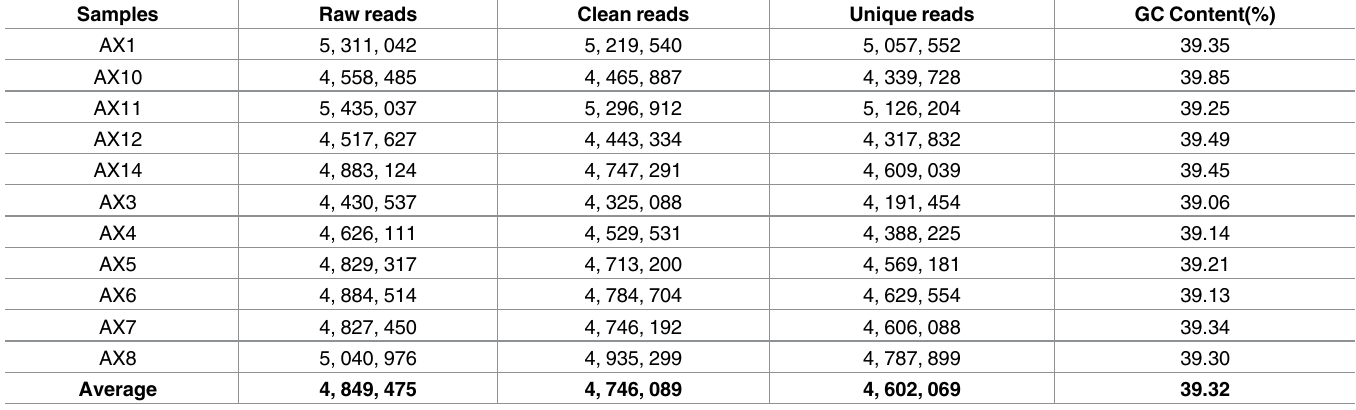
Table 1. Sequenced reads before and after quality